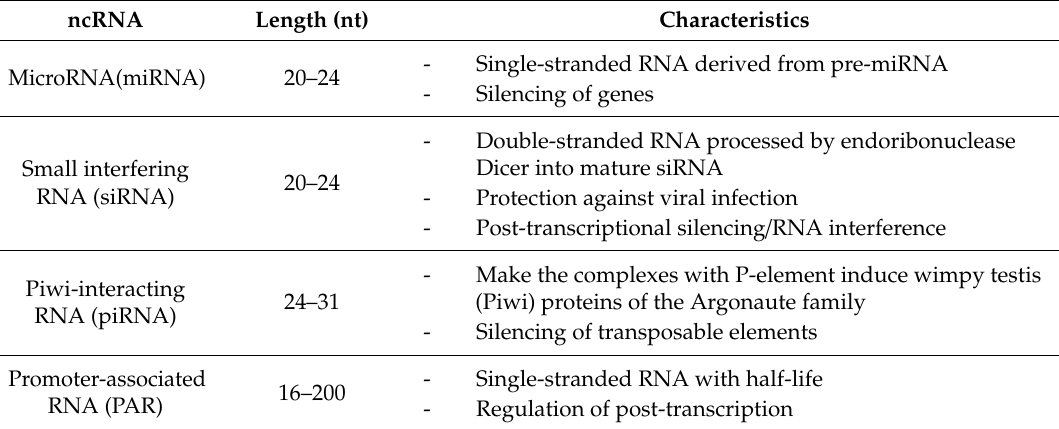
Table 2. The various non-coding RNAs (ncRNA) and their